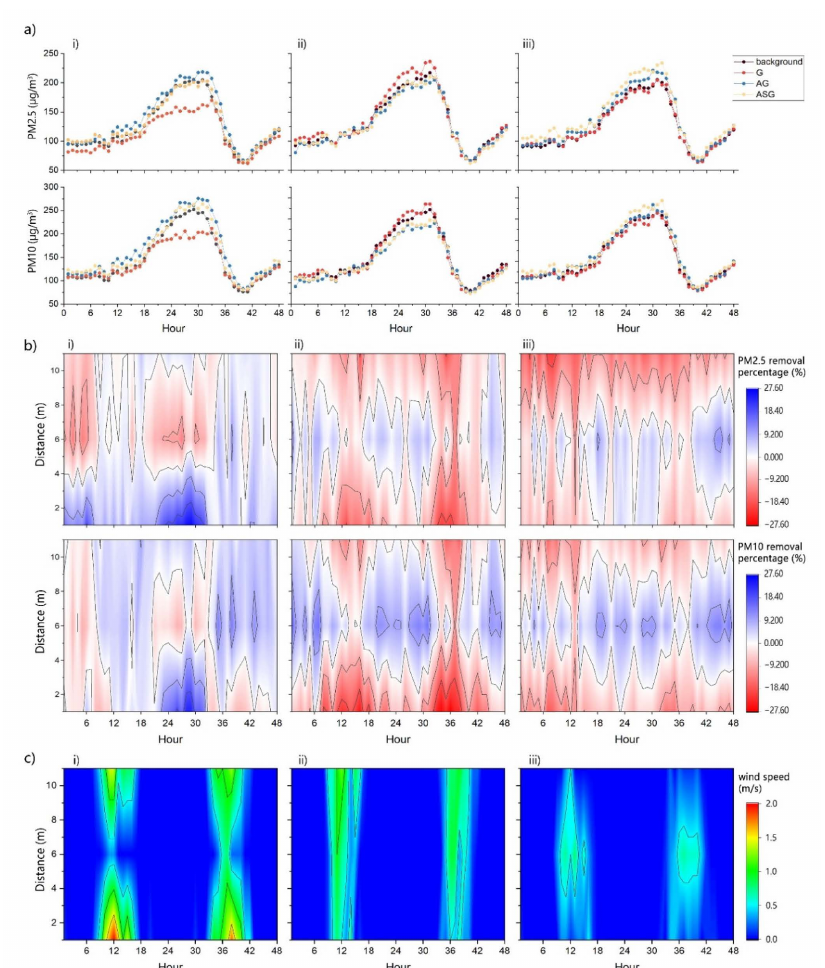
Figure 4. ( a ) Hourly trends in all three types of vegetation at (i) 1 m, (ii) 6 m, and (iii) 11 m distances from the river. ( b ) The spatial-temporal distribution of the removal percentages of the PM 2.5 and PM 10 in: (i) grassland (G); (ii) arbor-grass (AG) woodland; (iii) arbor-shrub-grass (ASG) woodland. ( c ) The spatial-temporal distribution of the wind speed in (i) grassland (G), (ii) arbor-grass (AG) woodland, and (iii) arbor-shrub-grass (ASG) woodland.